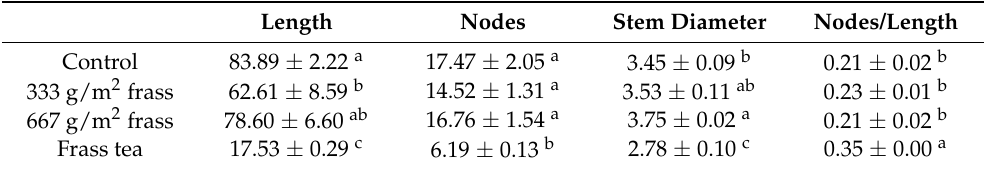
Table 3. Mean ( ± SE) length (cm), number of nodes, stem diameter (mm) and number of nodes/length of the sweetpotato slips after three weeks of being grown with black soldier fly ( Hermetia illucens ) larvae frass products or inorganic fertilizer.